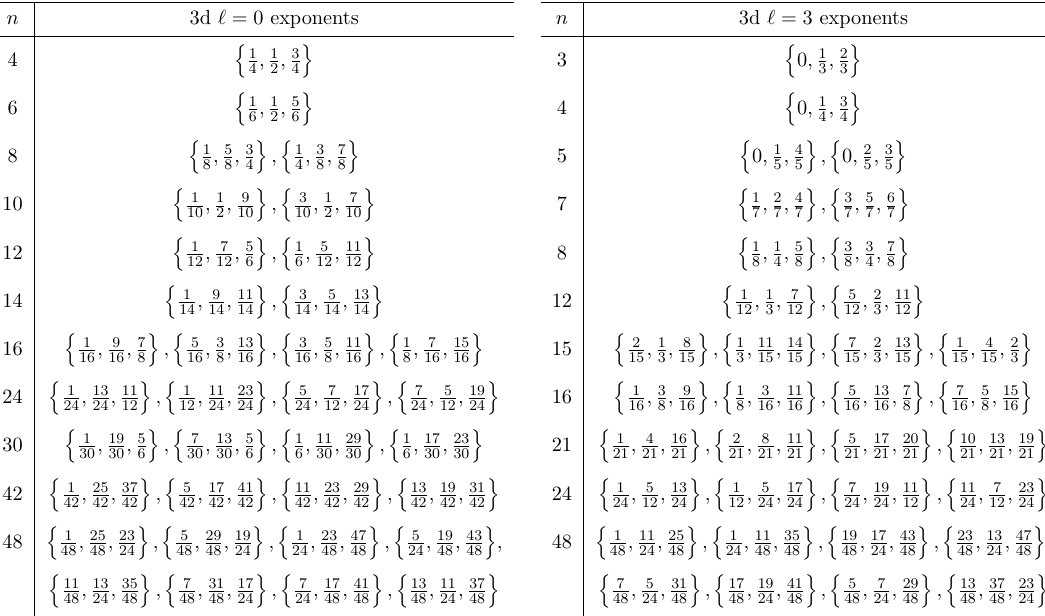
Table 12 . Possible exponents mod 1 for three-character theories, disallowing